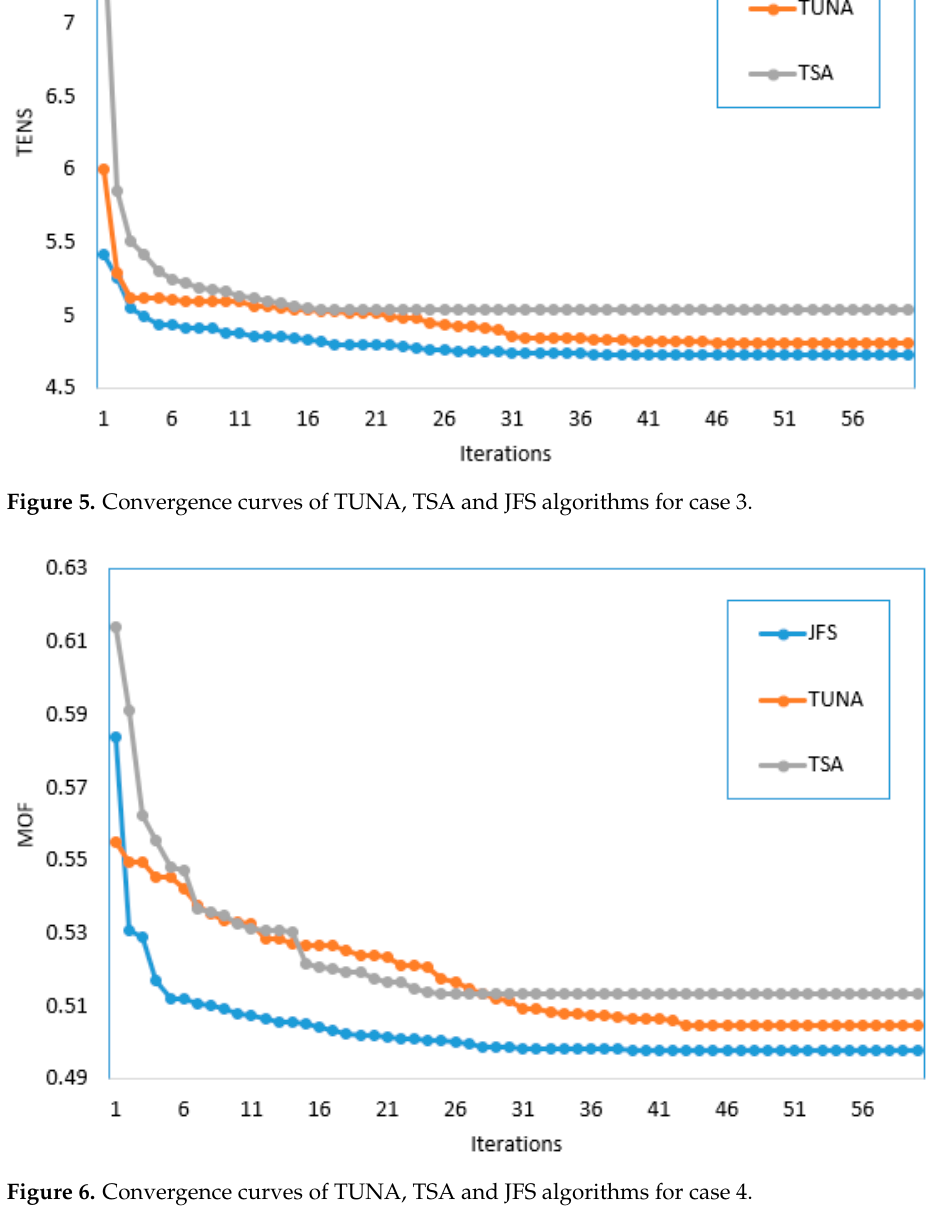
Figure 6. Convergence curves of TUNA, TSA and JFS algorithms for case 4.